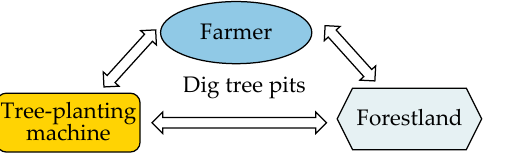
Figure 18. Initial scenario: Workers operate tree-planting machine to dig tree pit in the woodland.